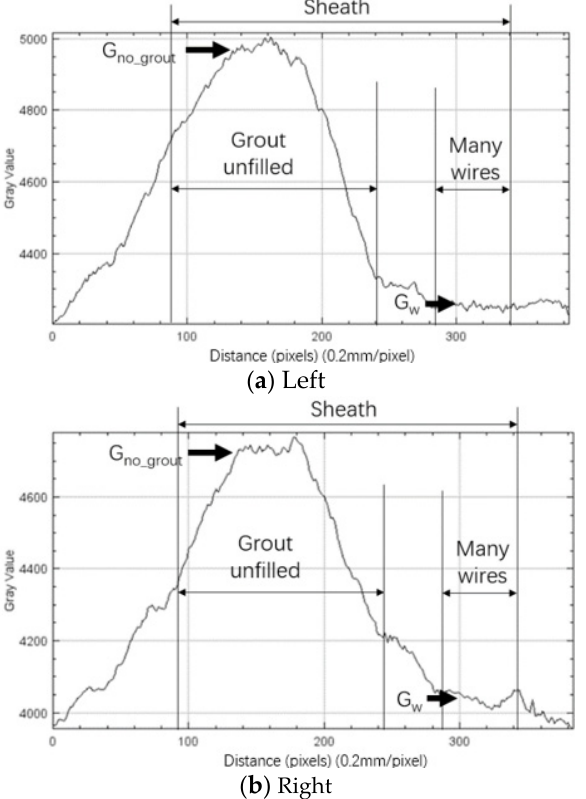
Figure 36. Gray value profiles of Figure 35. ( a ) Left; ( b )